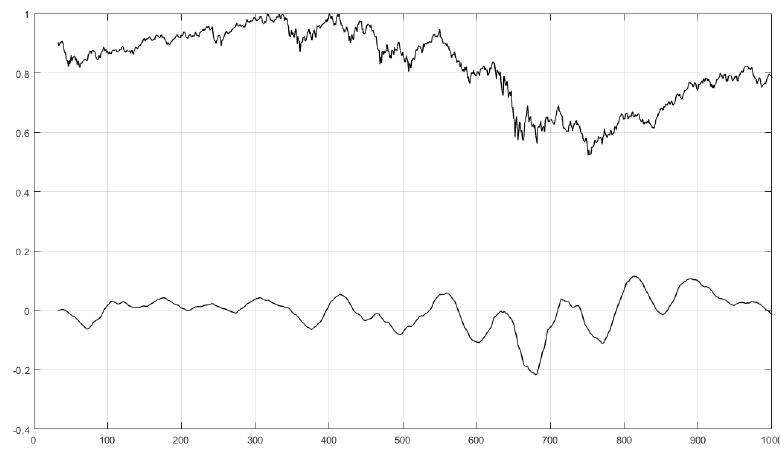
Figure 4. Example of computing the time varying Lyapunov exponent (lower signal) for a financial signal (upper signal after normalisation) through application of Equation (23) for a look-back window of size N = 32 and with τ =